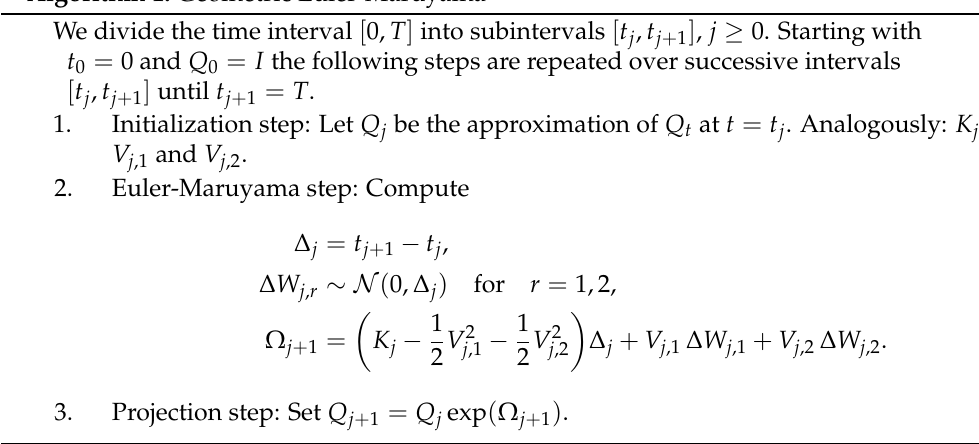
Algorithm 1: Geometric